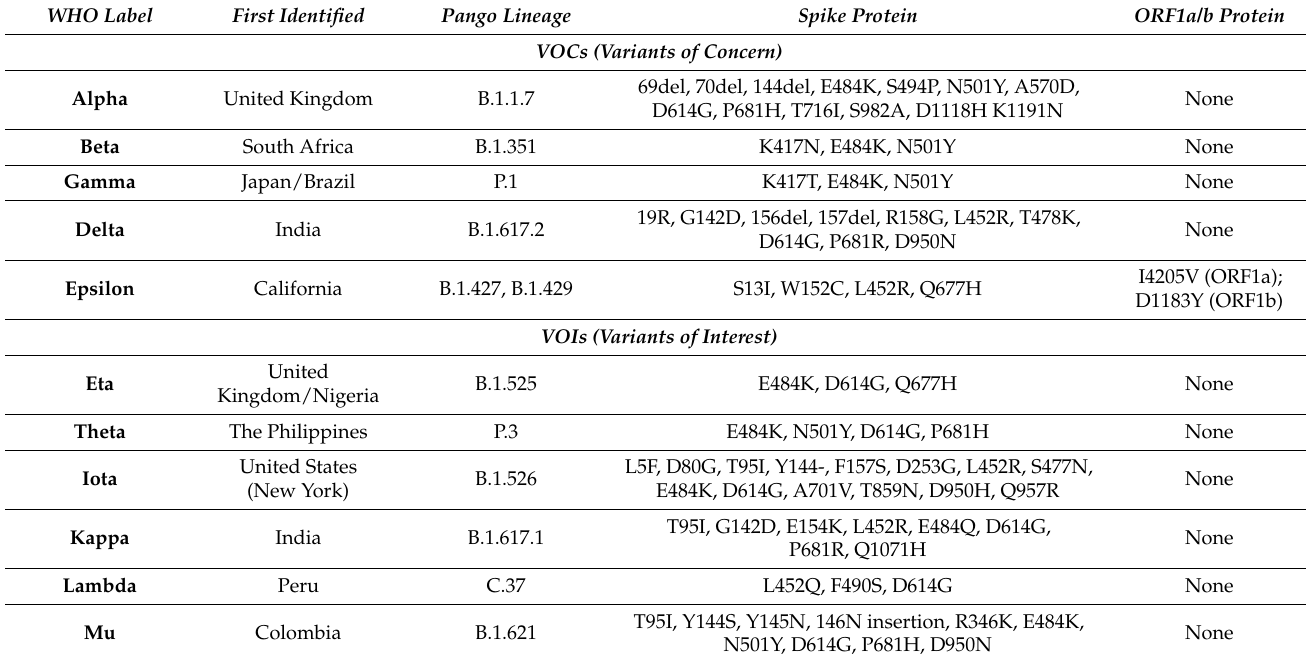
Table 1. SARS-CoV-2 variants and related